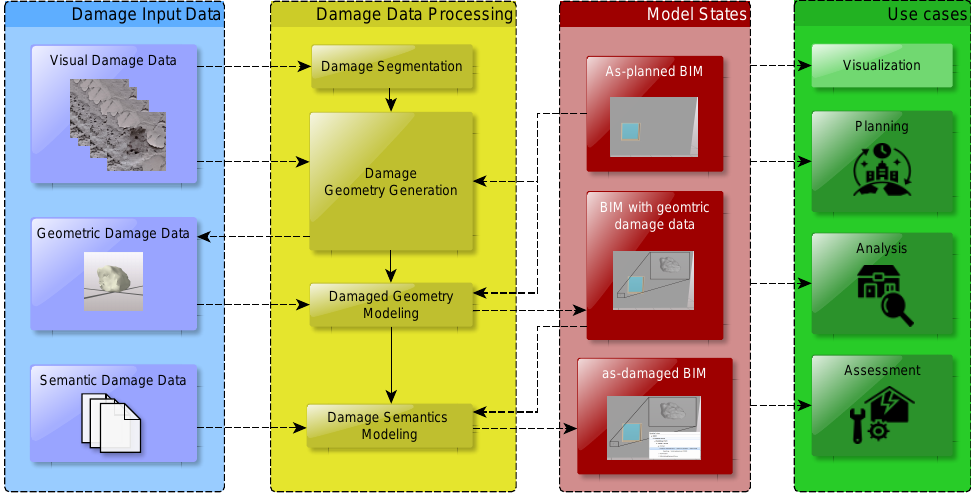
Figure 3. Overview of the framework with the damage input data, damage data processing, model states, and possible use cases. Pictograms have been taken from the Noun Project